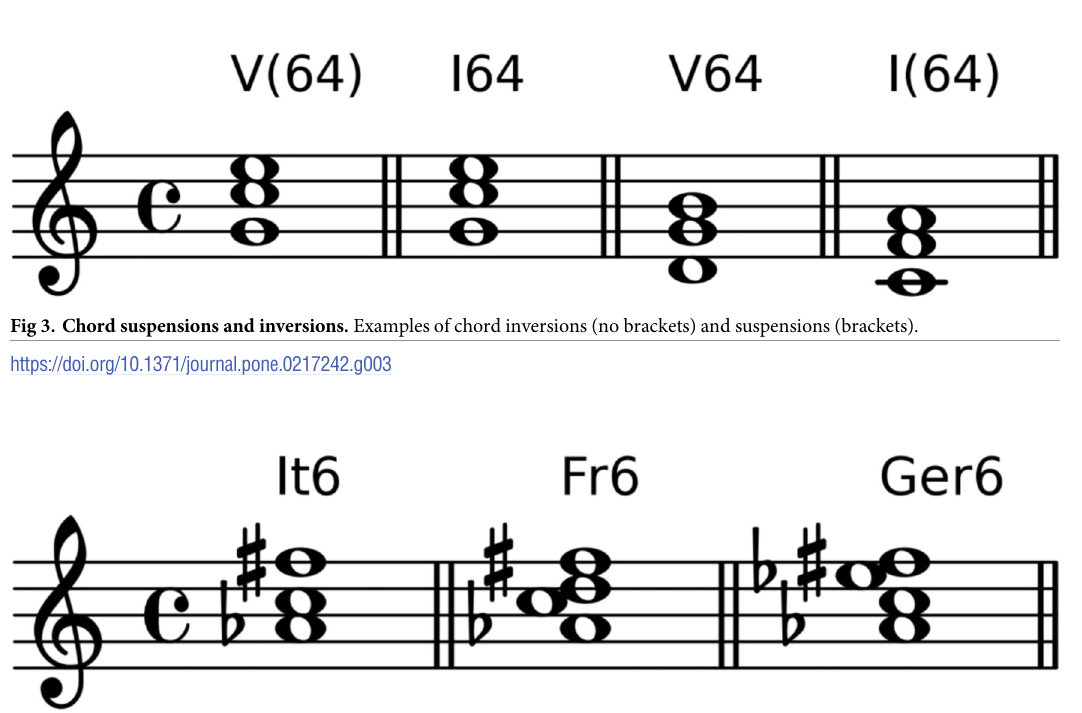
Fig 4. Augmented sixth chords. The Italian, French, and German augmented sixth chords in the key of C major.